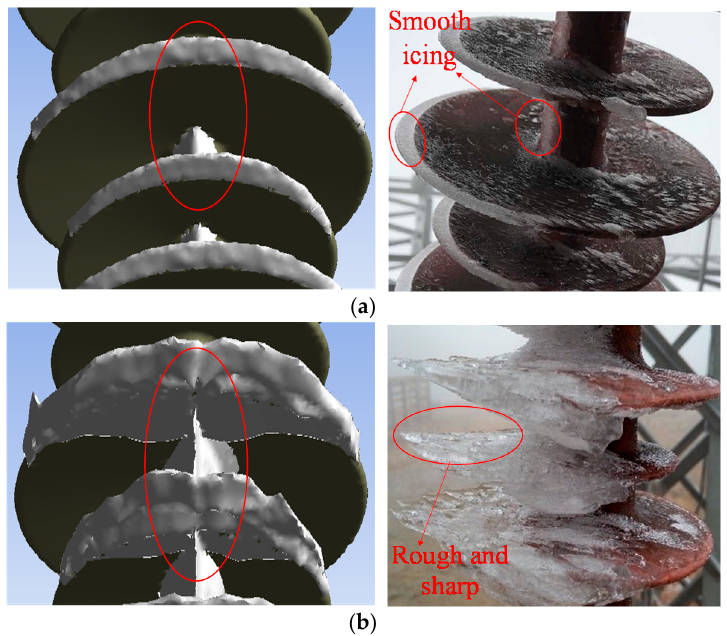
Figure 14. The changing roughness and sharpness of icing on windward side of insulator. ( a ) Initial stage of icing and ( b ) later stage of icing.